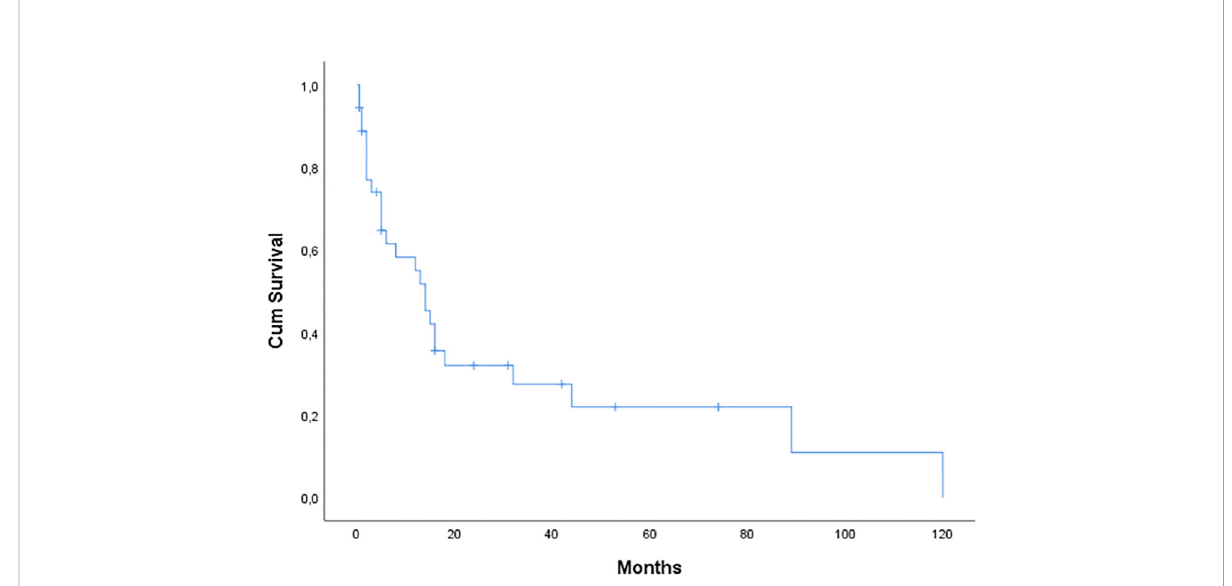
FIGURE 1 Kaplan-Meier curve of overall survival (OS) for 36 patients with AL amyloidosis seen at our center. Median OS was 14 months.